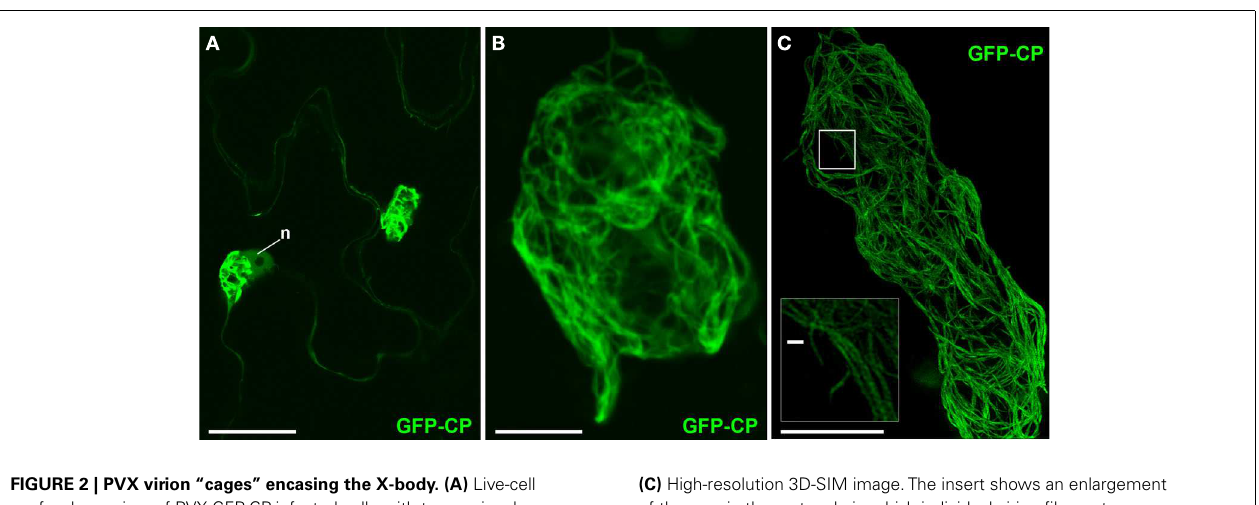
(C) High-resolution 3D-SIM image.The insert shows an enlargement of the area in the rectangle in which individual virion filaments are resolved to < 100nm diameter. Bars (A) : 50 µ m; (B,C) : 10 µ m; [insert in (C) ]: